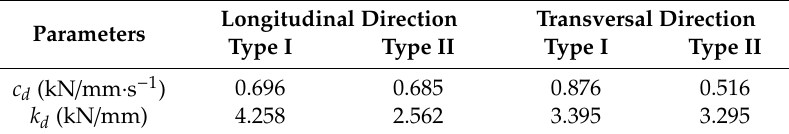
Table 1. The identified model parameters for monitored oil dampers.